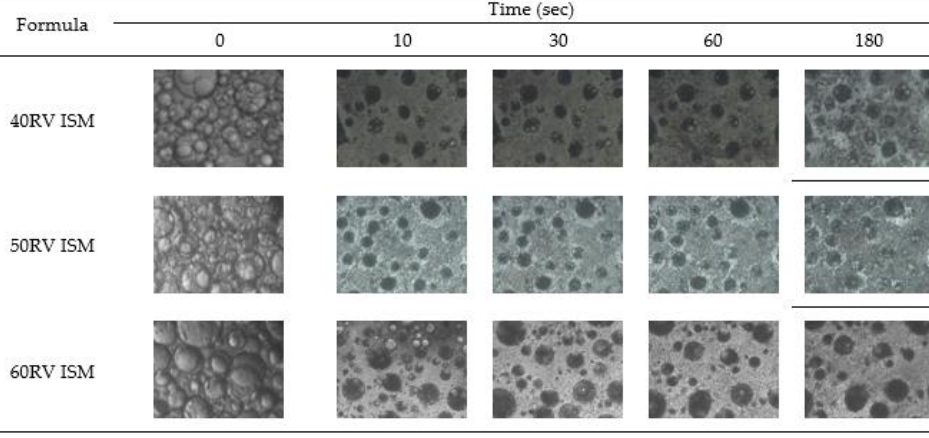
Figure 3. Microscopic transformation of vancomycin HCl-loaded ISM containing 40–60% ( w / w ) rosin under the inverted microscope.